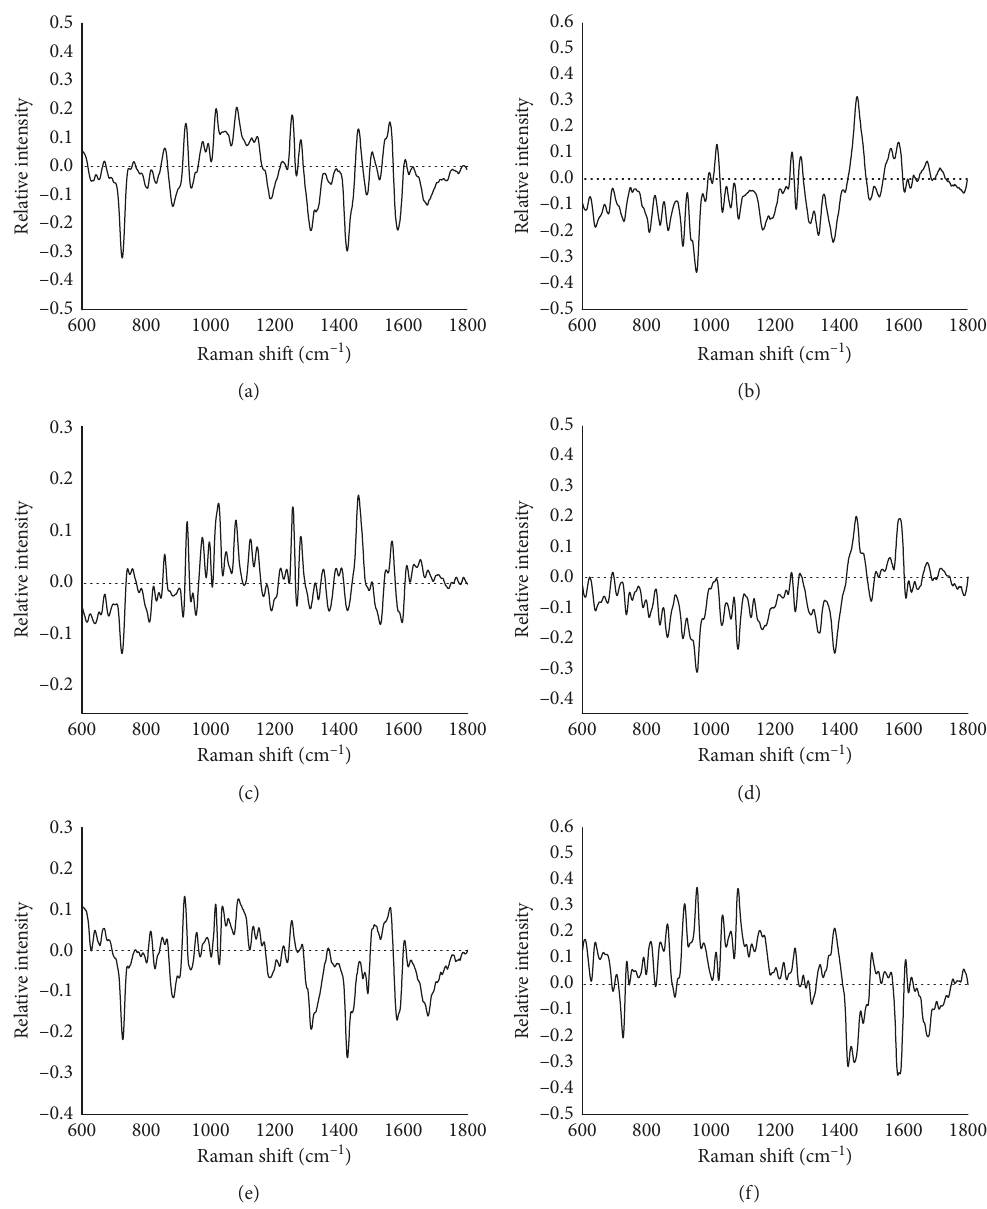
Figure 6: Difference spectra among the four groups were computed: (a) healthy subjects–large cell lung cancer, (b) healthy subjects–lung squamous carcinoma, (c) healthy subjects–lung adenocarcinoma, (d) lung adenocarcinoma–lung squamous carcinoma, (e) lung adenocarcinoma–large cell lung cancer, and (f) lung squamous carcinoma–large cell lung